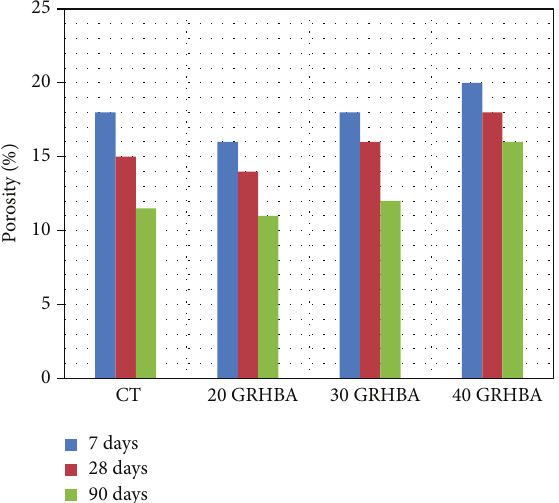
Figure 5: Normalized compressive strength of SCC.